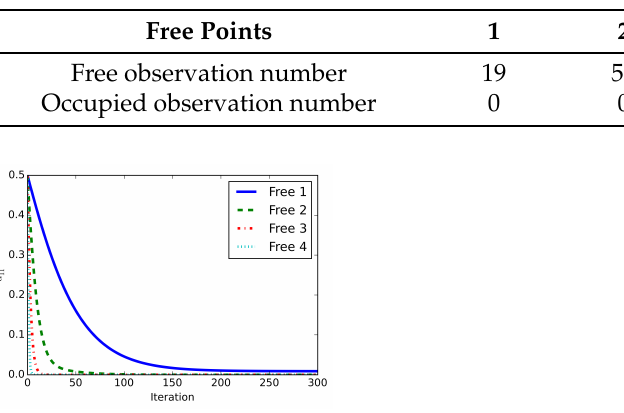
Figure 15. HMM parameter estimation of a 22 (free to free). Table 1. Observation numbers of the selected free points.